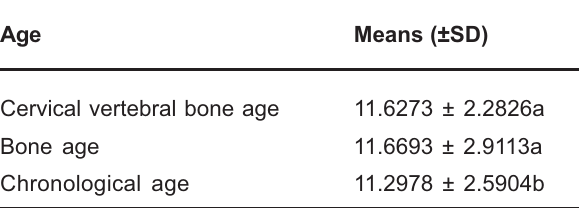
Different letters indicate statistically significant difference at 5% (Tukey’s test). TABLE 3- Means (±standard deviation) of cervical vertebral bone age, bone age and chronological age for the male population